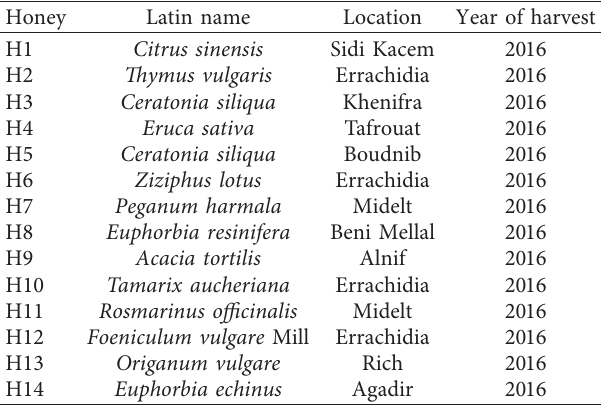
Table 1: Latin name, places of collection, and year of production of honey